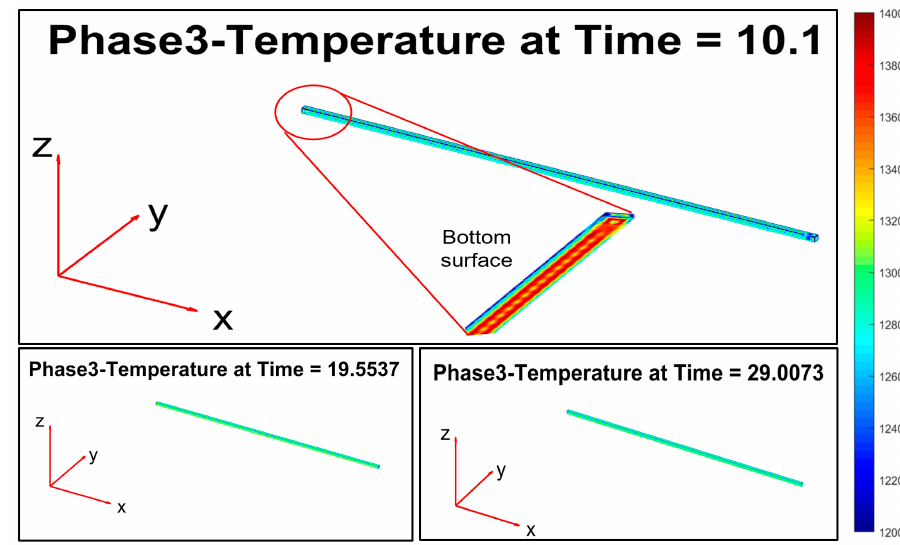
Figure 15. Modelization: phase 3 (movement between the descaler and stand 1).